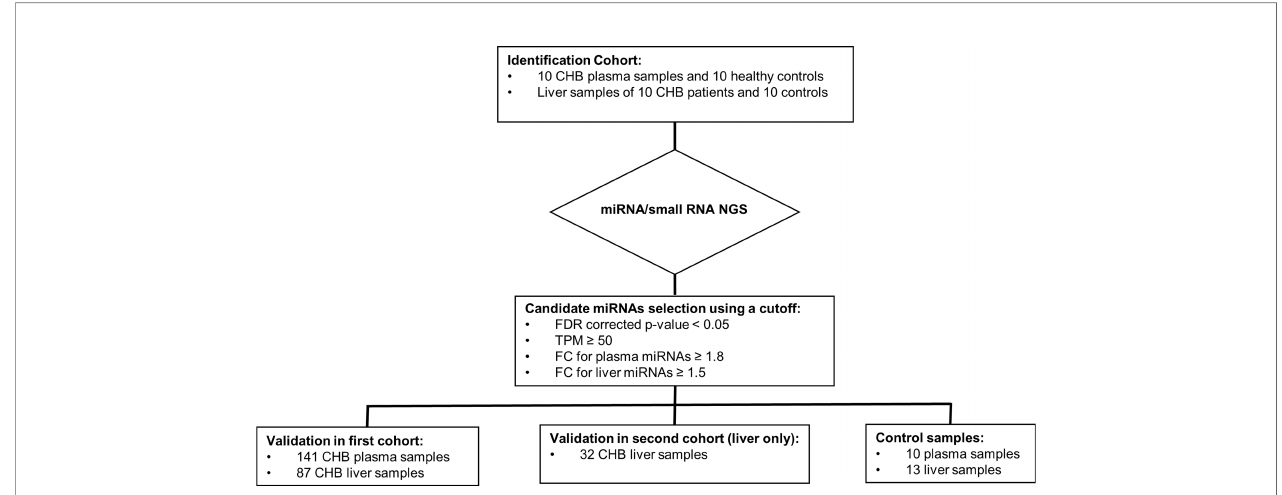
FIGURE 1 | The design of the study. The current study was performed in pretreatment plasma and liver tissue samples obtained from CHB patients participating in two independent CHB cohorts (Cohort 1: HBeAg-negative CHB patients with HBV DNA levels <20,000 IU/mL; Cohort 2: HBeAg-positive or -negative CHB patients with HBV DNA levels >17,182 IU/mL) and comprised two steps: the identi fi cation and the validation step. In the identi fi cation step, HBV associated miRNAs were identi fi ed in matching plasma and liver tissue samples of an identi fi cation cohort consisting of 10 CHB patients (selected from the fi rst CHB cohort) and 10 control samples by miRNA/small RNA NGS. In the validation step, candidate miRNAs were validated by qPCR in two con fi rmation cohorts that consisted of the remaining plasma (n=141) and liver samples (n=87) of the patients of the fi rst cohort, liver samples of the second cohort (n=32), and control plasma (n=10) and liver tissue samples